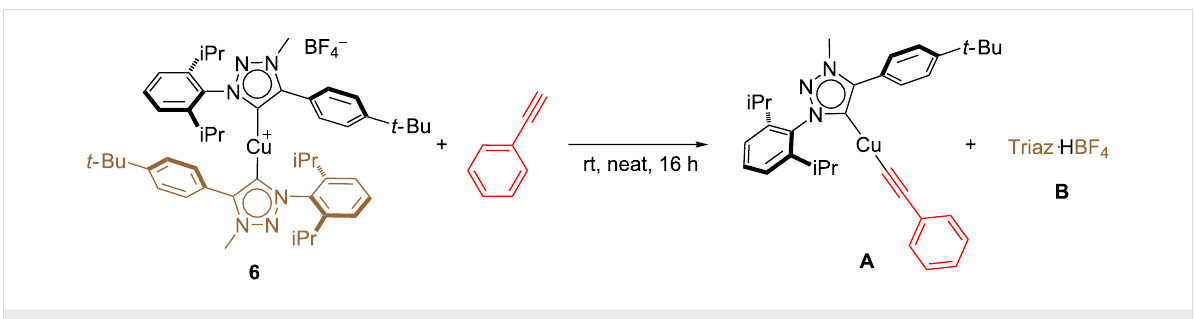
Scheme 8: Proposed mechanism for the formation of sulfonamidine.